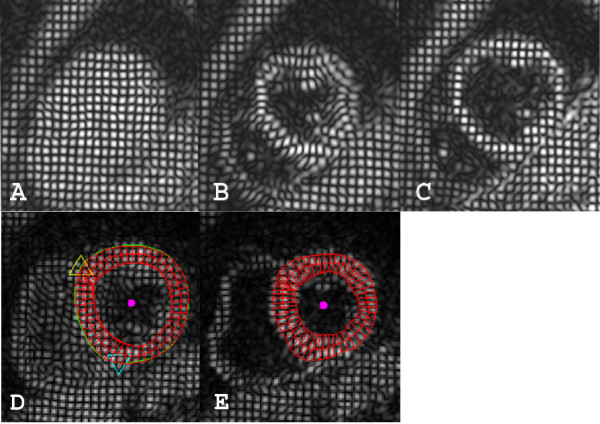
CSPAMM images of mid ventricular short axis slice and analysis model. A. Tags at the beginning of systole after ECG triggering. B. Same slice at end systole. C. Same slice at diastole with good persistence of tags. D and E show an example of CSPAMM images with the analysis model. D. In early systole, the epicardial border was manually drawn in green, endocardial border in red, superior right ventricular insertion site marked with a yellow triangle, and inferior insertion site marked with a blue triangle. The red donut is the analysis model with the myocardium partitioned in epi-myocardial, mid-myocardial, and endo-myocardial thirds shown in early systole in D and end-systole in E. Magenta dot is the center of the epicardial contour.